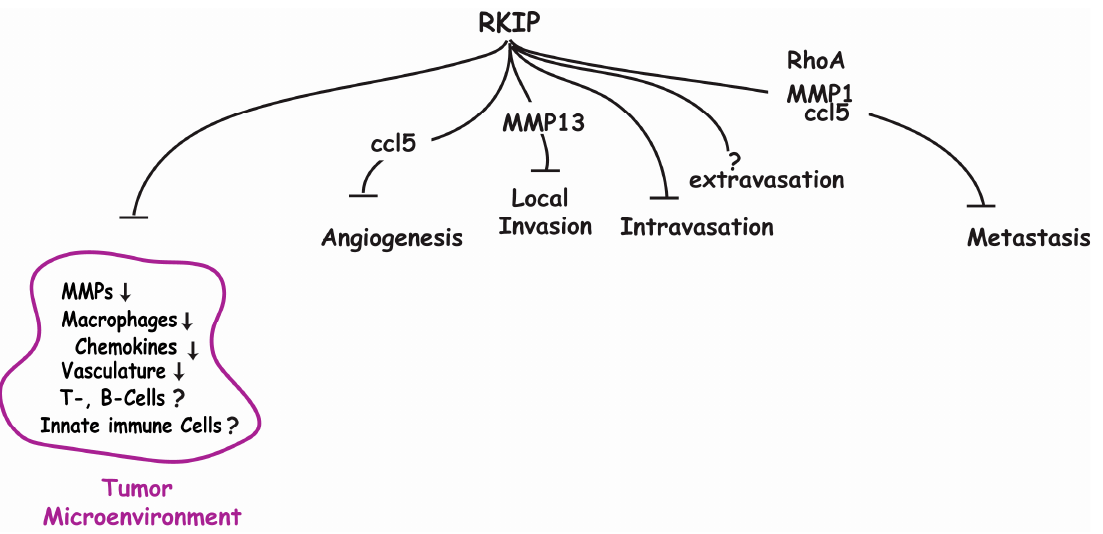
Figure 2. A schematic summary of the causal role of RKIP on the expression and effects of several proteins known to modulate the TME, and the metastasis cascade.